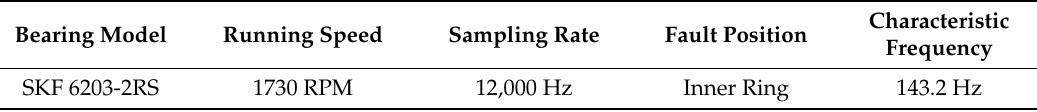
Figure 12. Experimental test stand. Left: Motor; center: Torque transducer; right: Dynamometer. Table 2. Experimental settings of case 2.